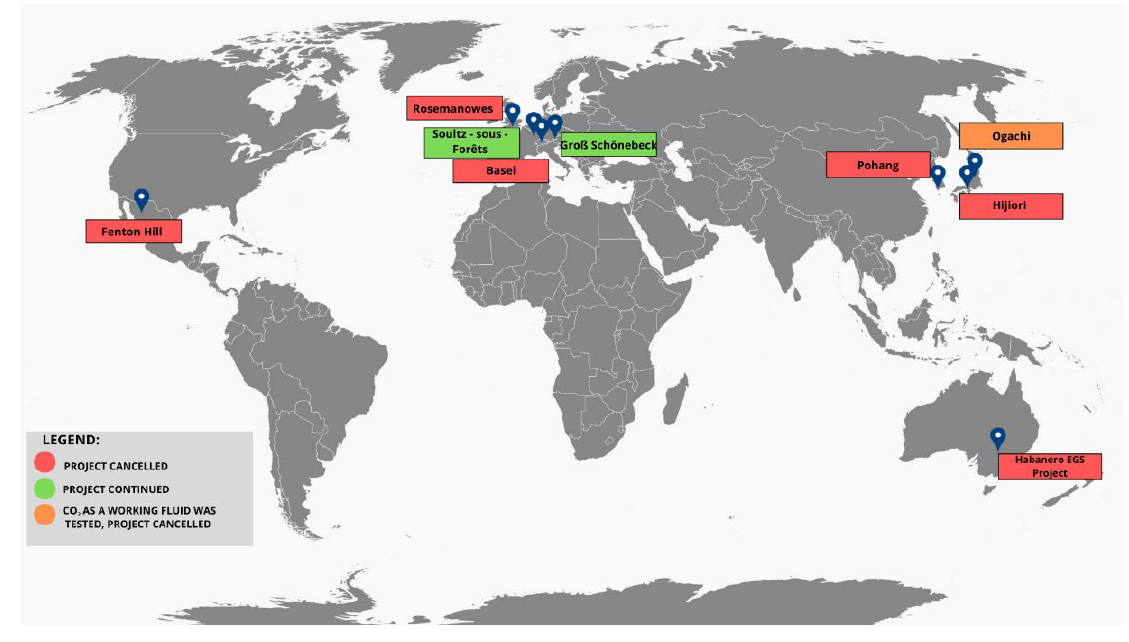
Figure 3. Map of EGSs described in the paper.